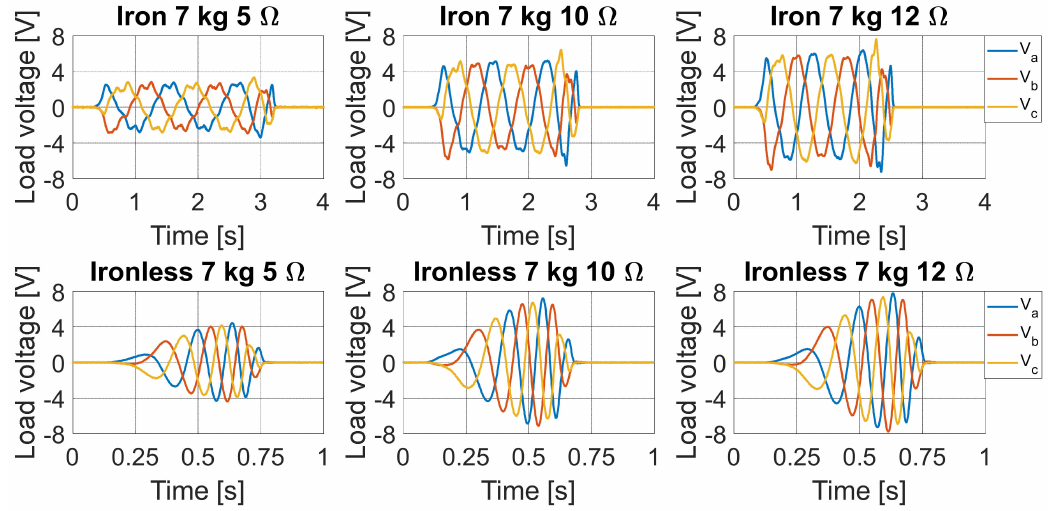
Figure 15. Load voltages trends of the 7 kg test with a resistance load equal to 5 Ω , 10 Ω and 12 Ω